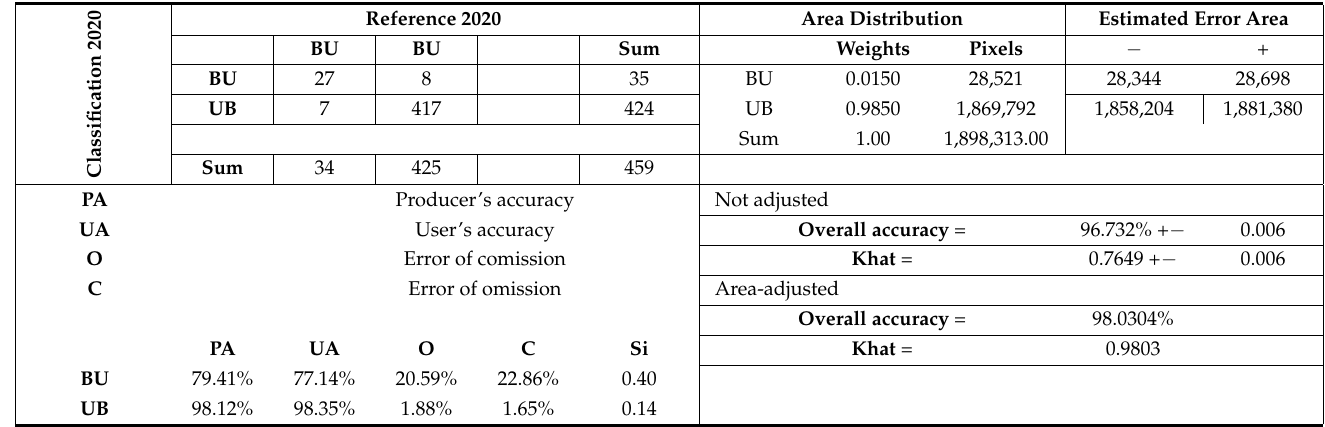
Table A3. Confusion matrices for 2020. BU: burned, UN: unburned.